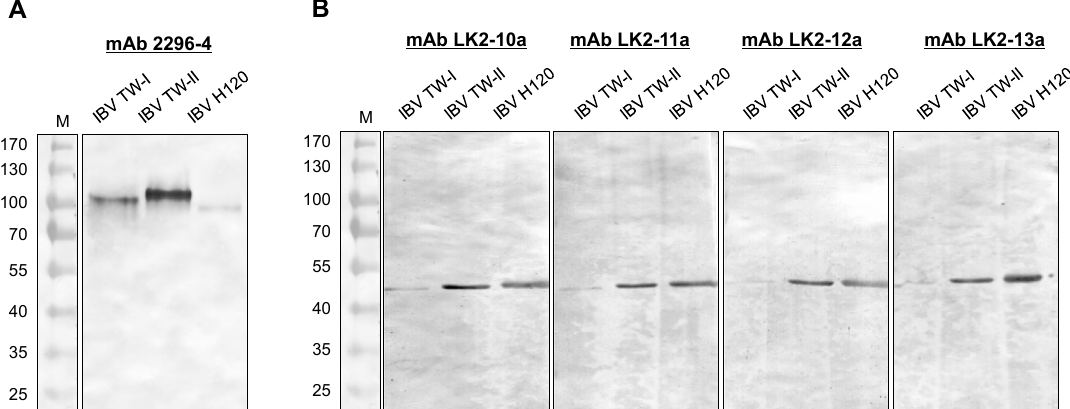
Figure 1. Characterization of monoclonal antibodies. Western blot was performed to verify the binding specificity of the monoclonal antibody (mAb) 2296-4, ( A ) LK2-10a, LK-11a, LK2-12a and LK-13a; ( B ) to the IBV TW-I, TW-II and